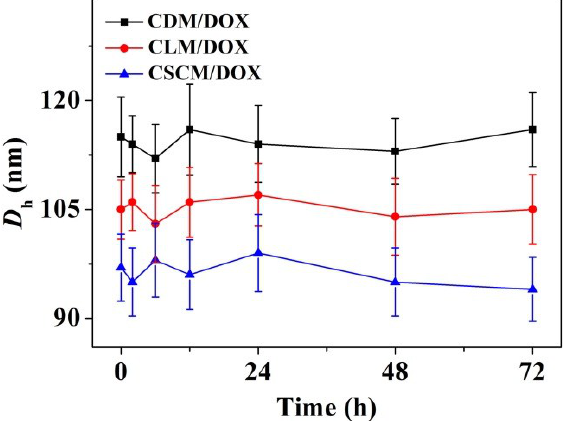
Figure 6. D h changes of CDM/DOX, CLM/DOX, and CSCM/DOX versus time in PBS-buffered BSA solution (30.0 mg mL −1 ) at pH 7.4, 25 °C. Each set of data was presented as mean ± SD ( n =